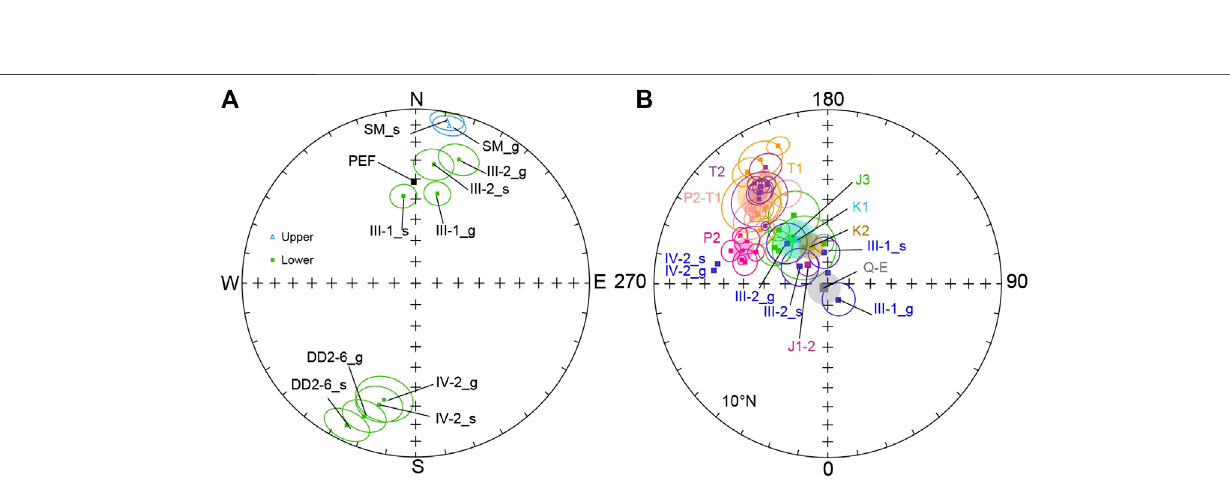
Frontiers in Earth Science |